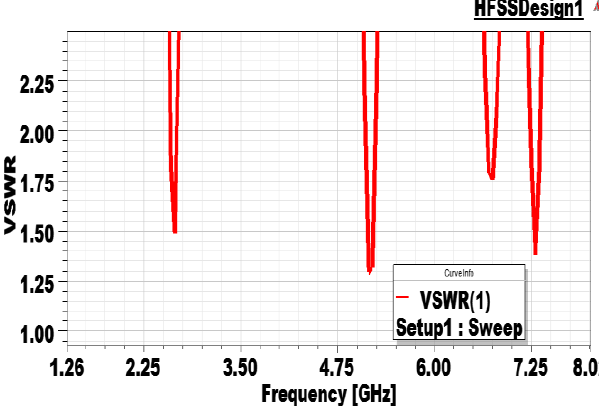
Figure 9. Simulated VSWR of the proposed configuration